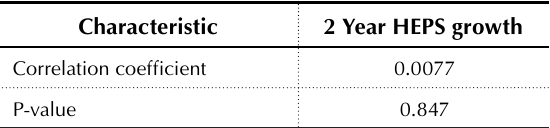
Table 3. Correlation